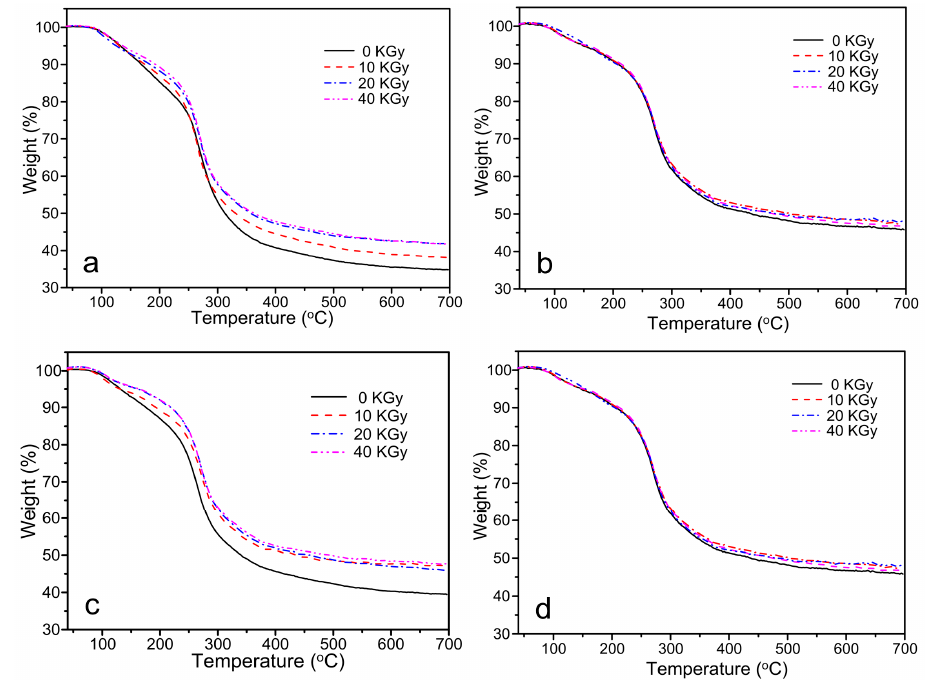
Figure 6. Thermogravimetric analysis (TGA) analysis of CS/GO composite films with different content of GO: ( a ) 0 wt %; ( b ) 1 wt %; ( c ) 3 wt %; ( d ) 5 wt % under the various irradiation doses.